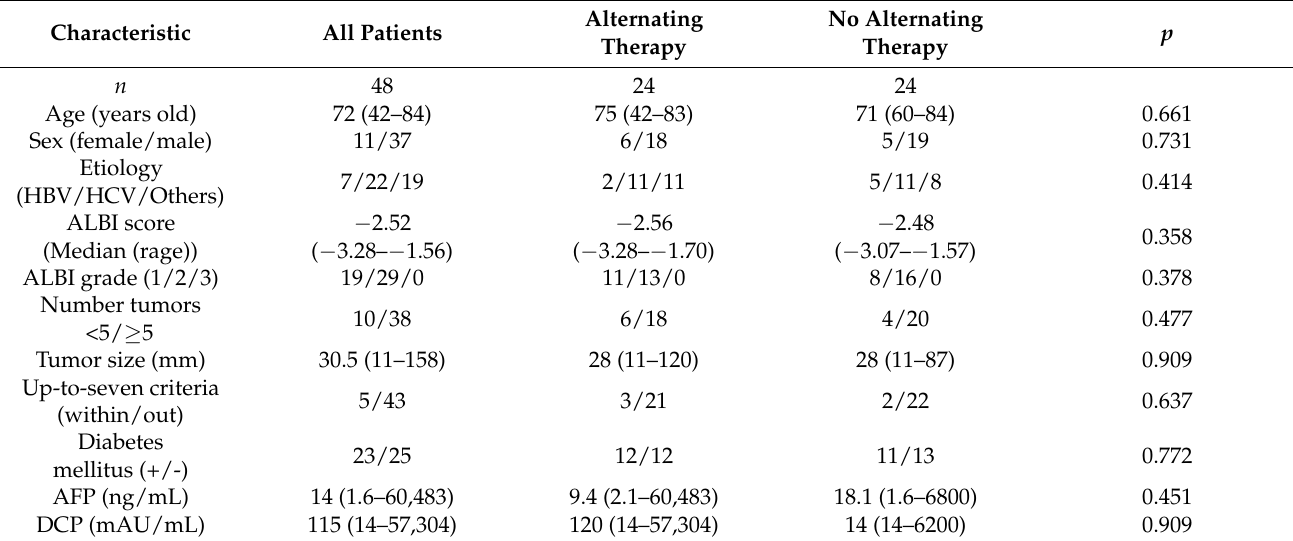
Table 2. Patient characteristics after propensity score